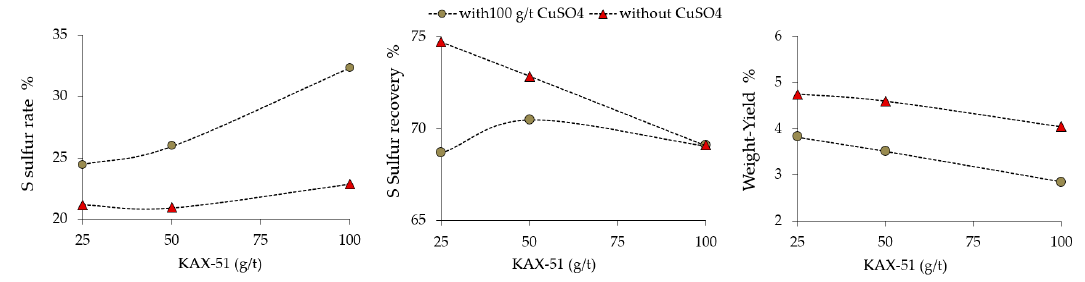
Figure 3. Yield weight and sulfur recovery during flotation tests (desulfurization).